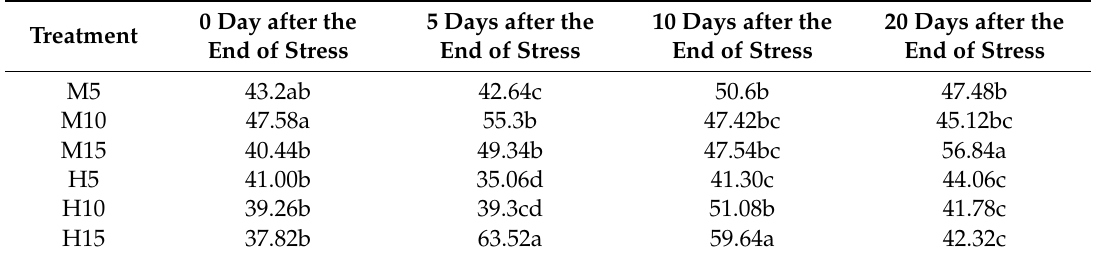
Table 4. Thickness of the outer root ( µ m) after exposure to high temperature and waterlogging stresses.